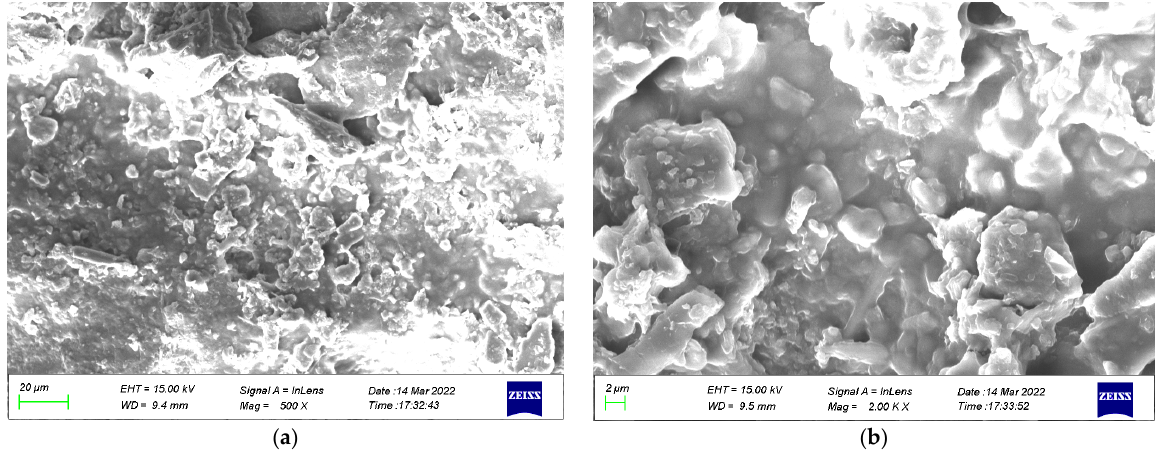
Figure 17. Micro-structure of aggregate, WER content 5%: ( a ) 500×; ( b ) 2000×.